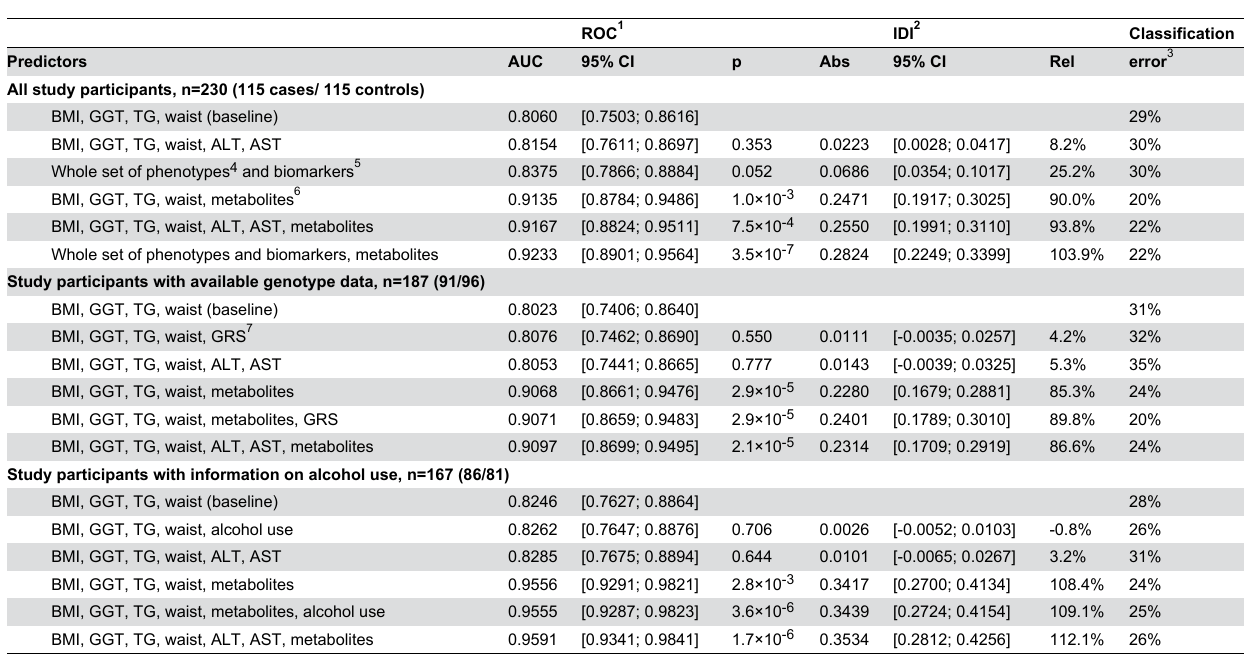
Diagnostic models are based upon logistic regression models. 1 Diagnostic models were evaluated by reference to AUC, the area under Receiver Operation Characteristics (ROCs) curves. P values were obtained by DeLong’s approach of comparing AUC between potentially related models. 2 Reclassification was assessed by the integrated discrimination improvement (IDI). The IDI is based upon the change, from one model to another, in terms of the so-called ‘discrimination slope’, defined as the difference in average FLD risk between cases and controls. Whereas the absolute IDI value of two models measures the classification improvement by the difference between their discrimination slopes, the relative IDI value equals the ratio of their discrimination slopes. 3 The performance of each diagnostic model was evaluated by 10-fold cross-validation with an equal number of cases and controls in each partition. 4